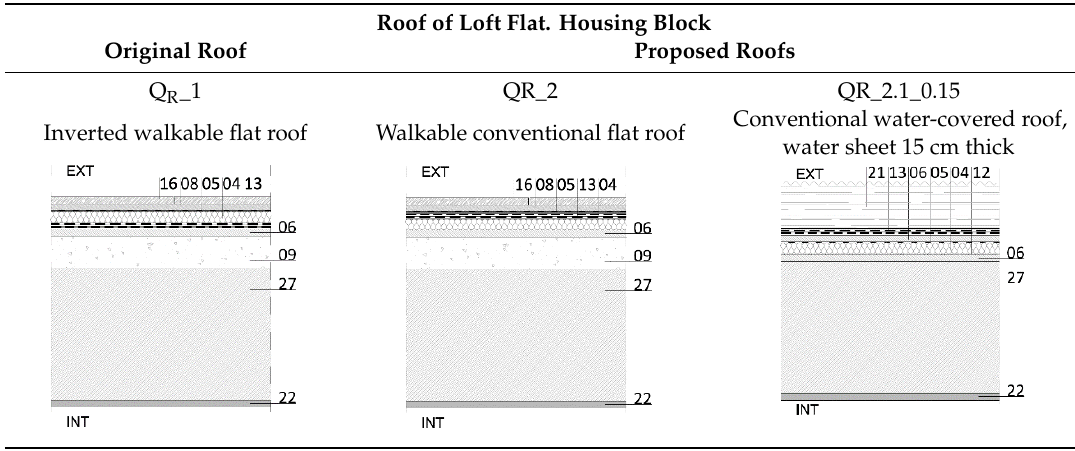
Table 5. Construction section of the apartment’s inverted flat roof and its derivatives.